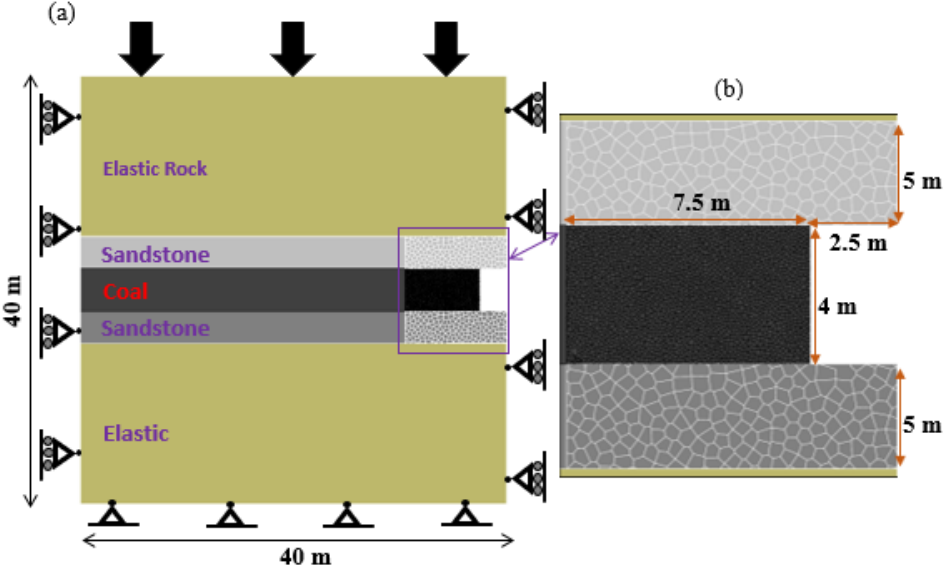
Figure 8. ( a ) Model boundary conditions and geometry configuration, ( b ) Voronoi tessellation zone logic